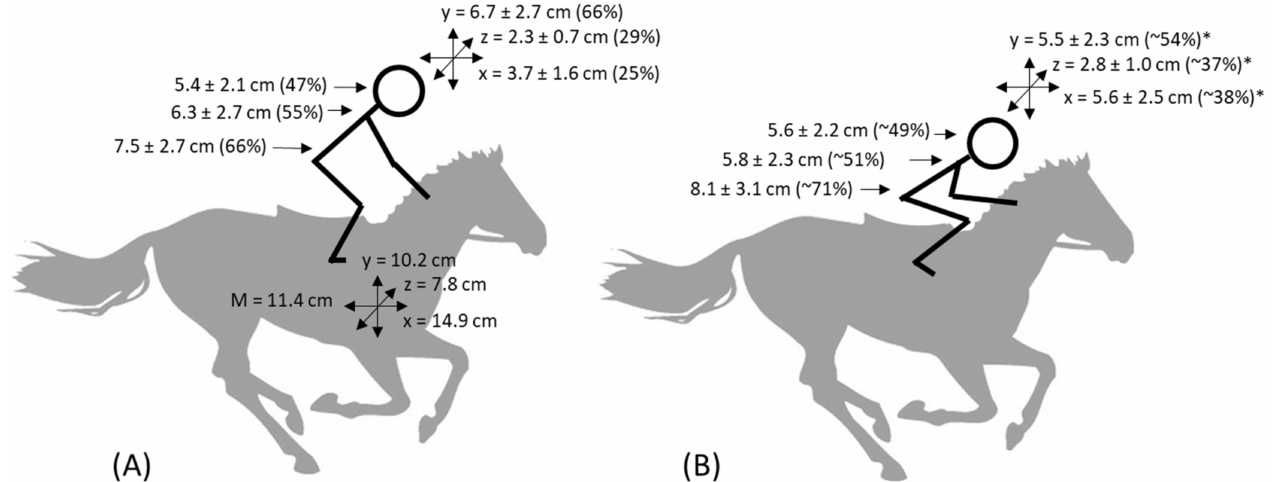
Figure 1. Mean magnitude (M) of displacements (cm) and relative displacement (%) of jockey to a horse galloping in ( A ) Trials and ( B ) Races, and in the vertical (y), fore/aft (x), and medio/lateral (z) planes. Horse displacements were measured only for horses racing in trials. All differences between jockey and horse (at trials) displacement are significant ( p < 0.05). * Denotes differences between jockey displacement in trials and races ( p <